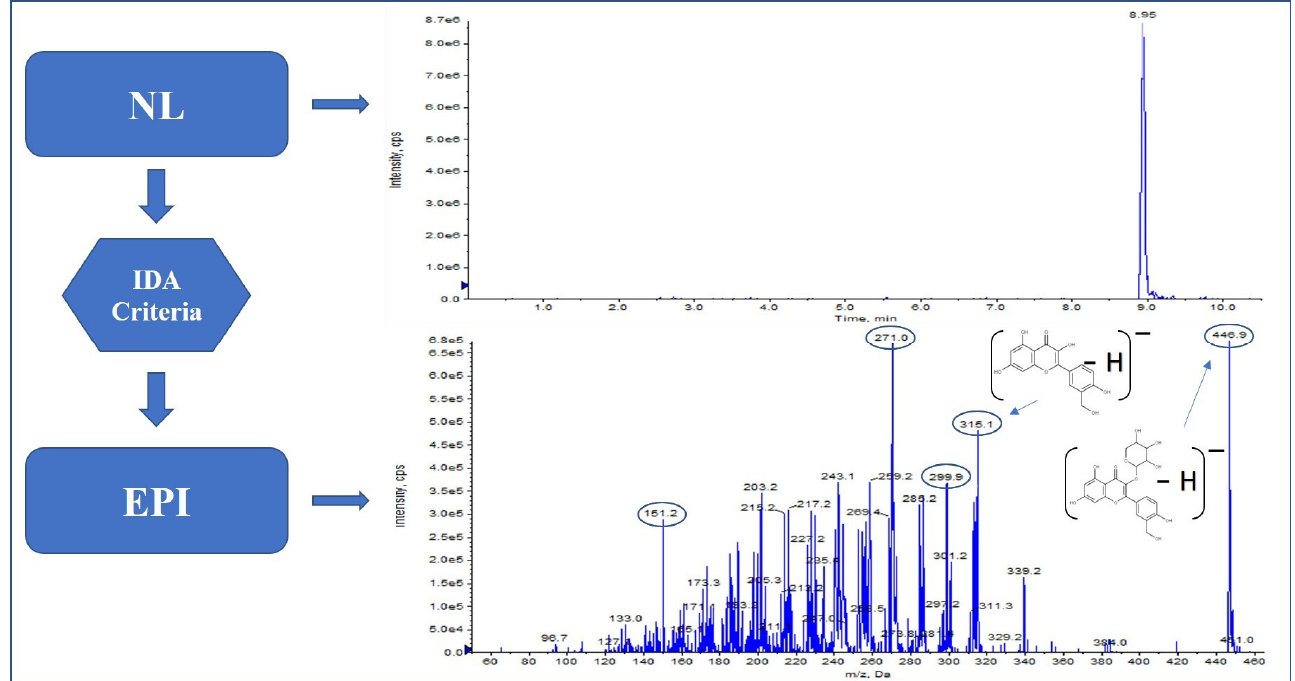
Figure 4. Isorhamnetin-xyloside pattern in hop.